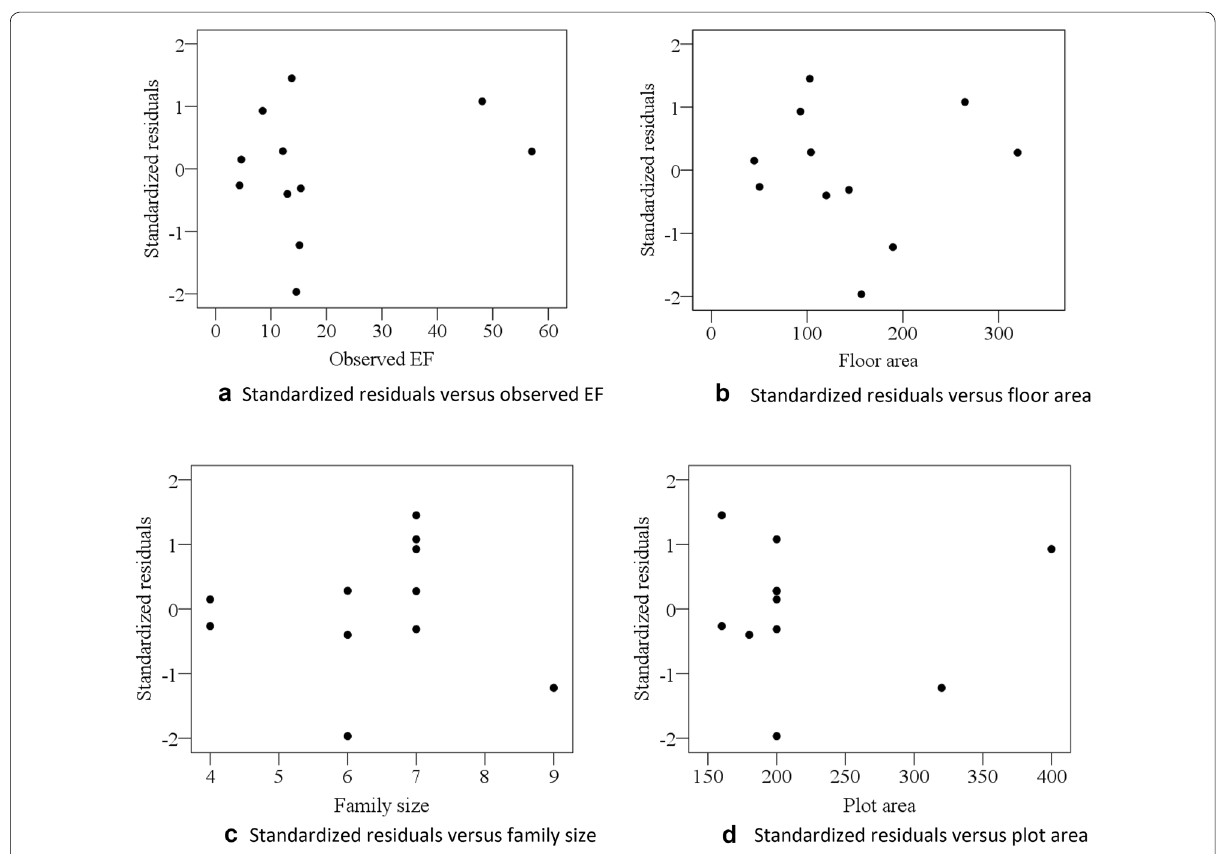
Fig. 6 Standardized residuals plotted against the predicted values ( a ) and each of the three independent variables ( b – d